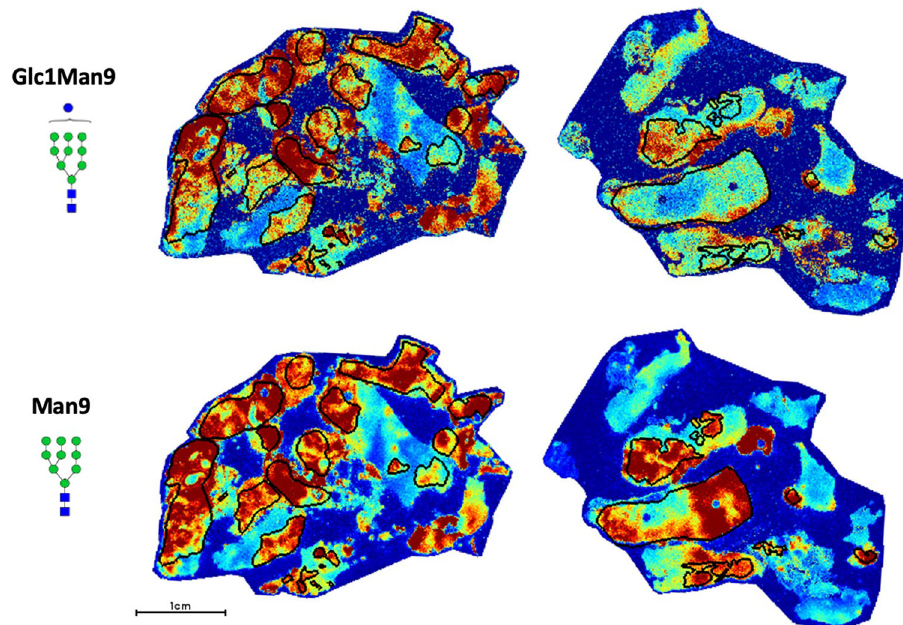
Fig. 7 Representative glycan image demonstrating Glc1Man9 and Man9 localization within demarcated tumor regions (black circles) in two hormone resistant PCa cases. Both glycans demonstrate high speci fi city for tumor